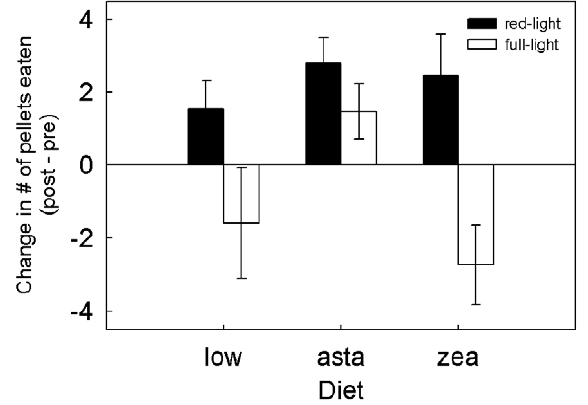
Figure 4. Carotenoid supplementation and foraging perfor- mance. Mean 6 S.E. change in the number of food pellets eaten by finches in the red-filtered light (solid bars) and the full light (open bars) following eight weeks on a low carotenoid, astaxanthin- (asta) supplemented, or zeaxanthin- (zea) supplemented diet.